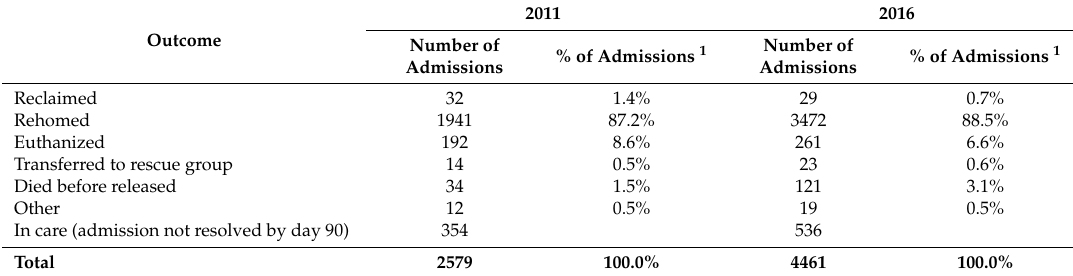
Table 5. Distributions of outcomes by day 90 after admission for admissions to RSPCA Queensland shelters in 2011 and 2016 where the cat was fostered by the 30th day after